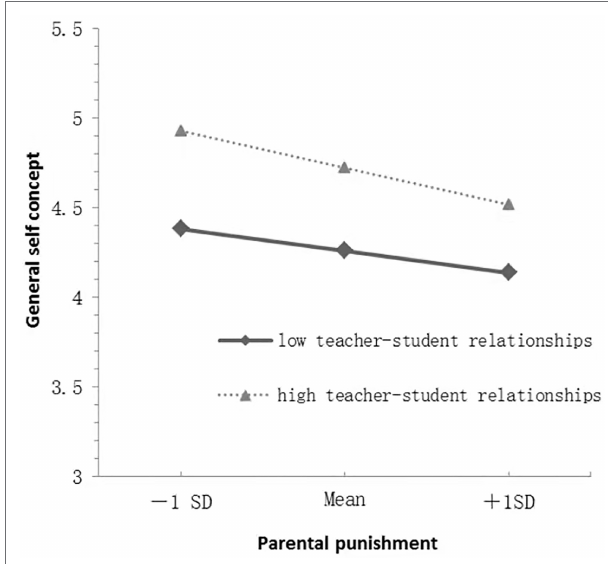
FIGURE 2 | Plot of the interaction between parental punishment and teacher-student relationships on general